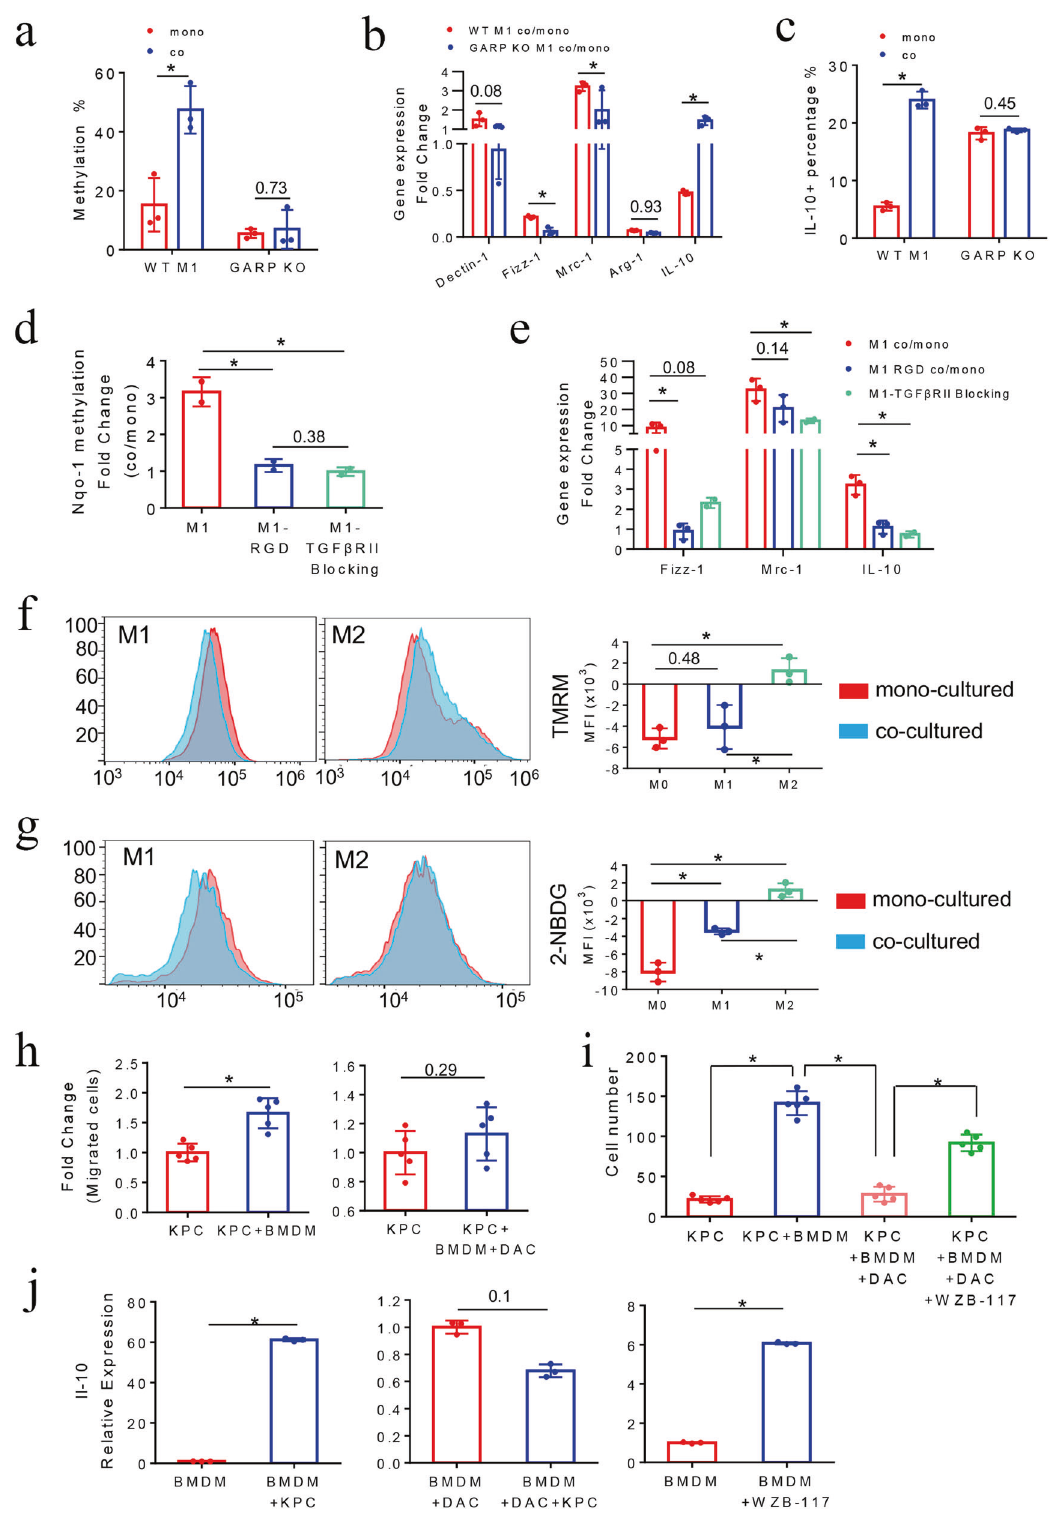
Thus, the above results support a reprogramming of glucose metabolism and OXPHOS genes in TAMs through tumor-induced DNA methylation. We further studied the glucose metabolic states of macrophages after co-culturing with PDA cells by using TMRM to measure mitochondrial membrane potential and 2-NBDG, a glucose analog to measure glucose intake. Higher TMRM